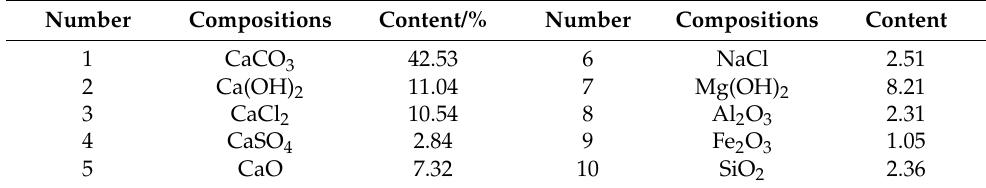
Table 1. Main chemical composition of SR.